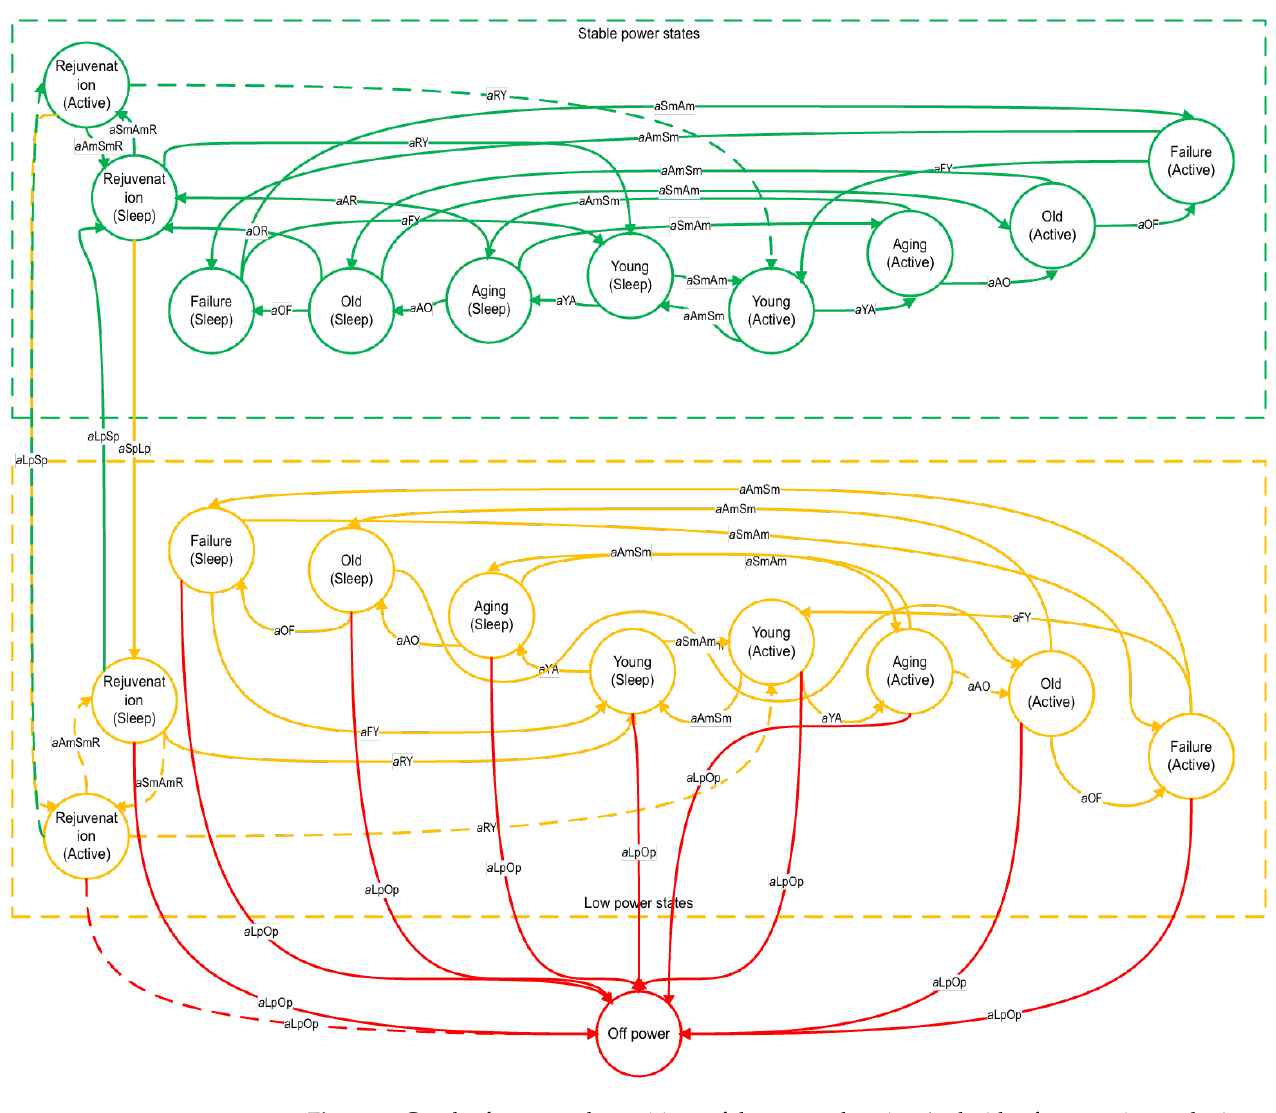
Figure 7. Graph of states and transitions of the comprehensive Android software aging and rejuvenation model.